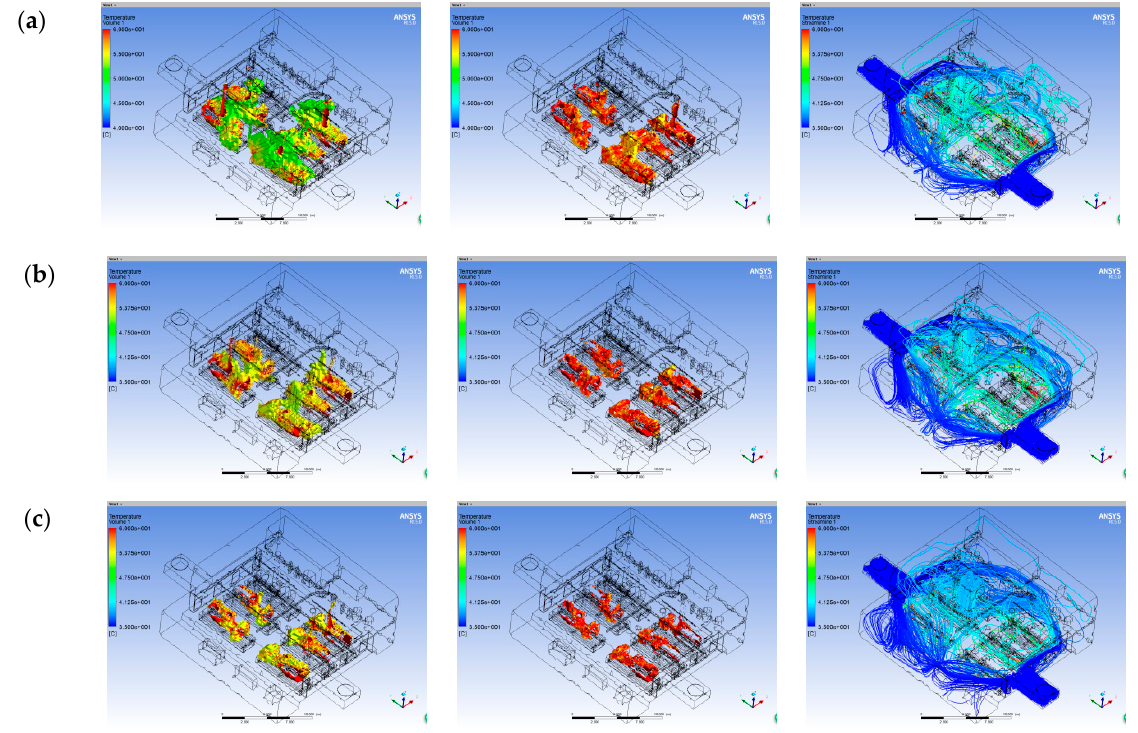
Figure 9. High-temperature volumes above 50 and 55 °C, and temperature streamlines between 45 and